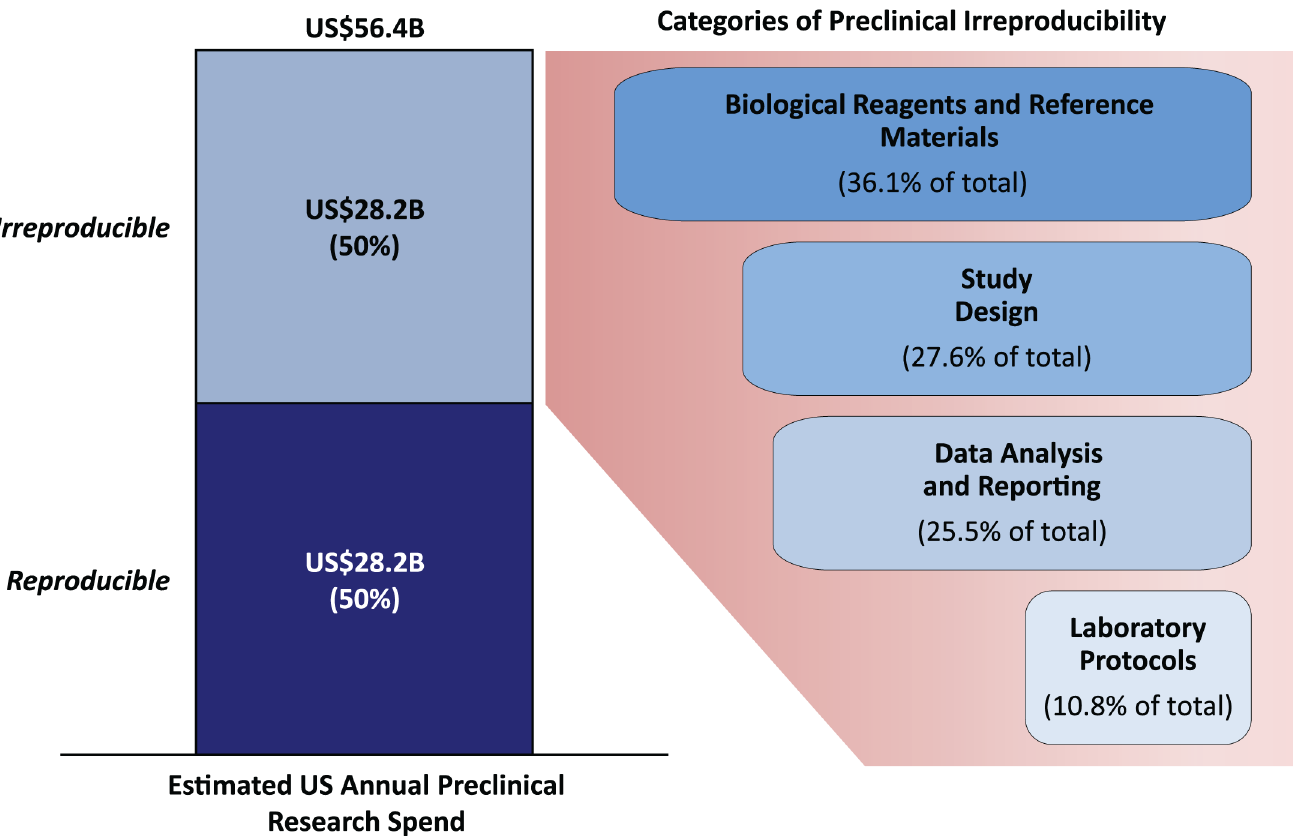
Fig 2. Estimated US preclinical research spend and categories of errors that contribute to irreproducibility. Note that the percentage value of error for each category is the midpoint of the high and low prevalence estimates for that category divided (weighted) by the sum of all midpoint error rates (see S1 Dataset). Source: Chakma et al. [18] and the American Association for the Advancement of Science (AAAS)